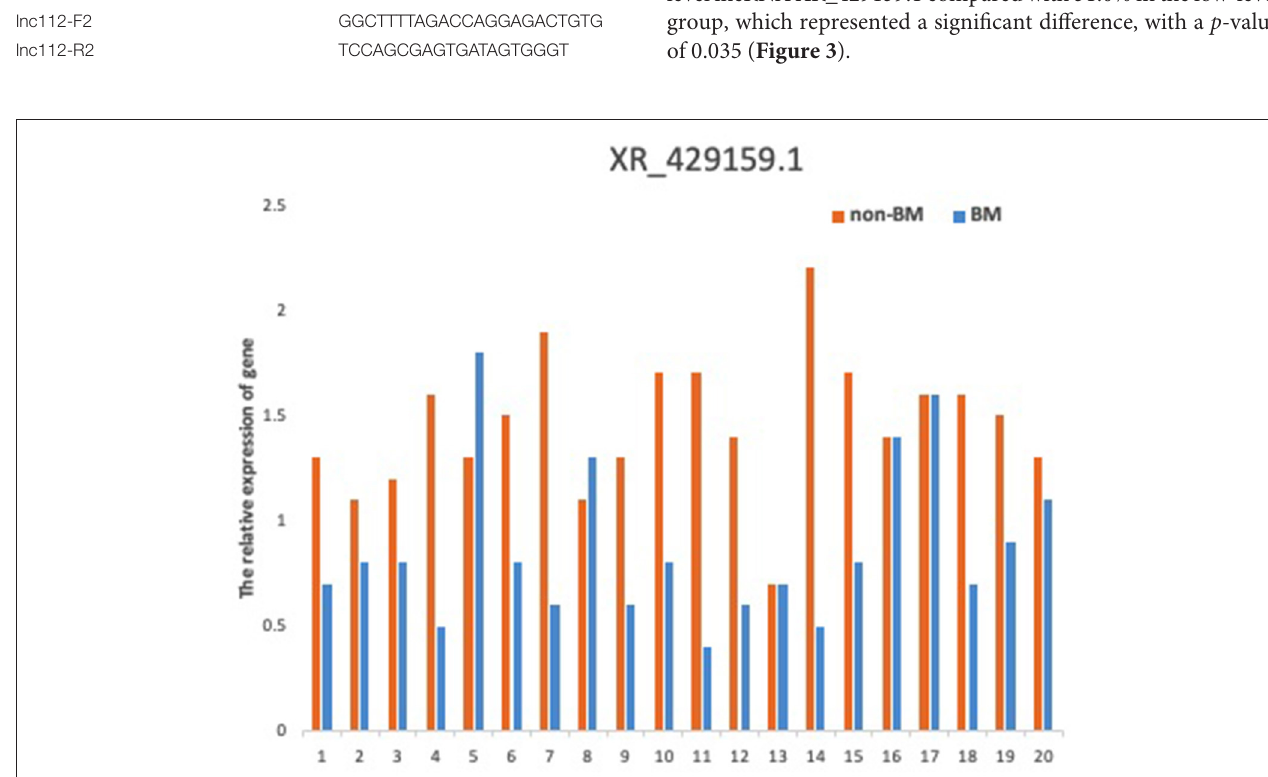
FIGURE 2 | The comparison between LncRNA XR_429159.1 levels between 20 pairs of patients with and without BM.